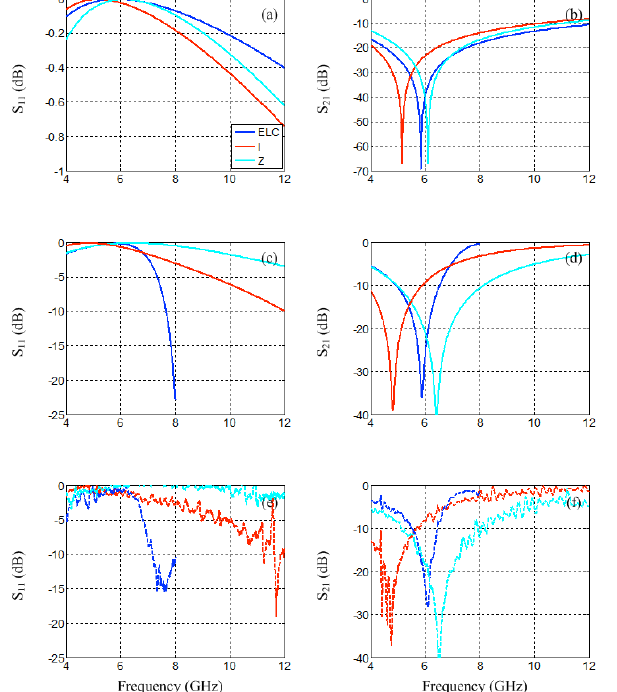
Figure 3: (a)-(b) Calculated from equivalent circuit model, (c)-(d) computed from full-wave simulations, and (e)-(f) measured reflection and transmission responses of the different resonators.